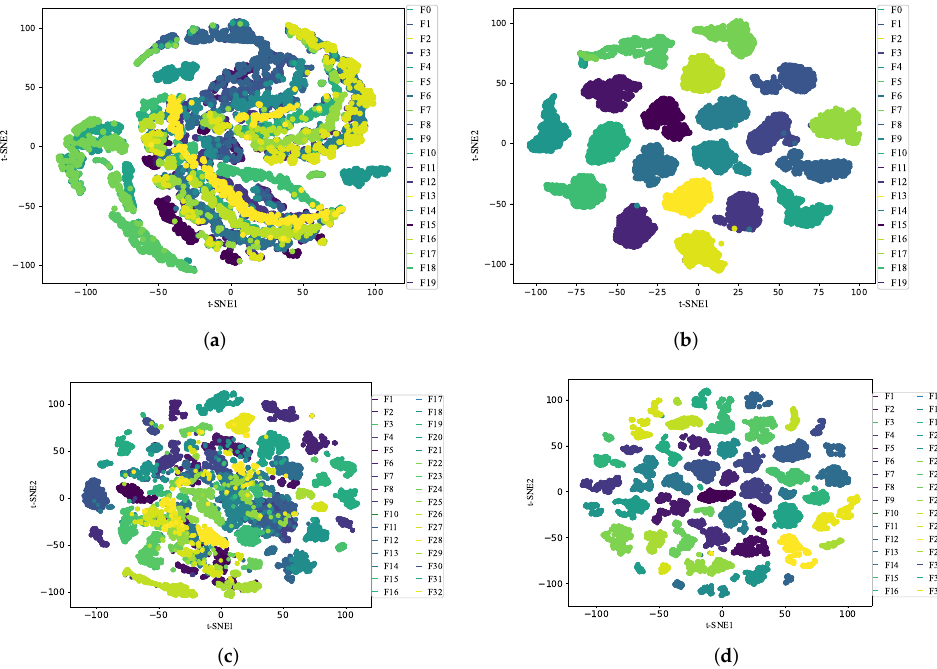
Figure 9. Feature visualization with t-SNE: ( a ) Raw SEU data space, ( b ) AE-MSGCN learning space of SEU, ( c ) Raw CMO dataset space, ( d ) AE-MSGCN learning space of